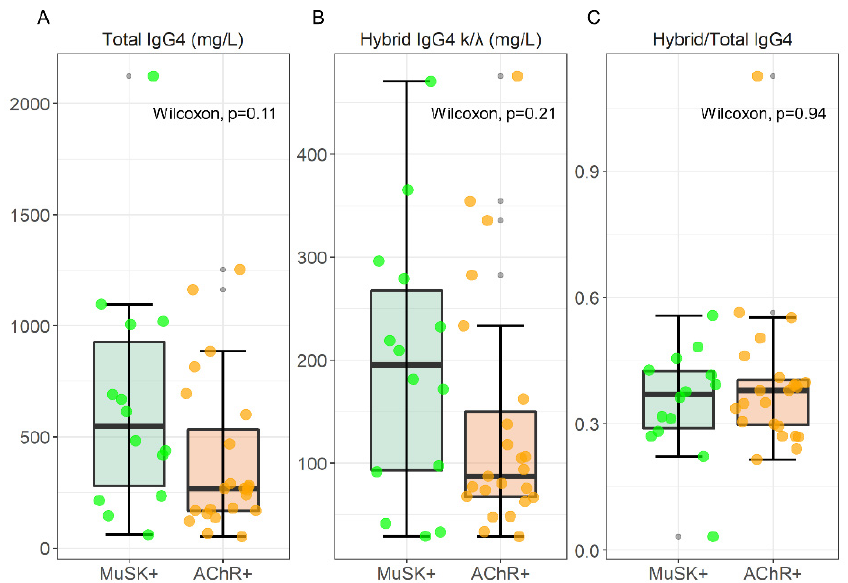
Table 1. IgG4 determinations in 14 MuSK and 24 AChR-MG sera.